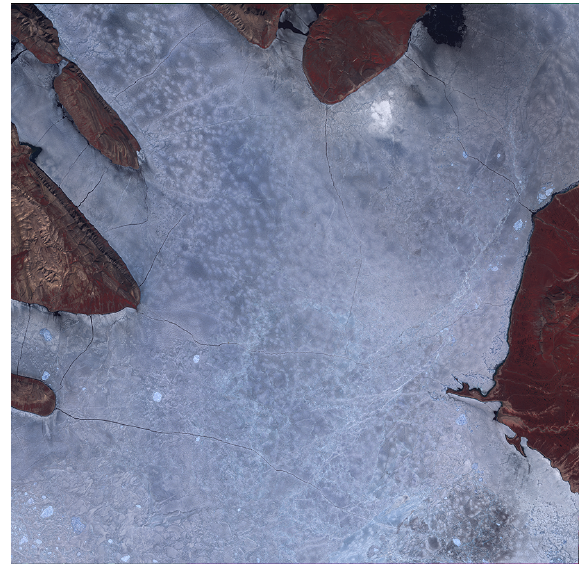
Figure 1: False color composite of the nadir bands of the “Sea Ice” scene used for most figures of this